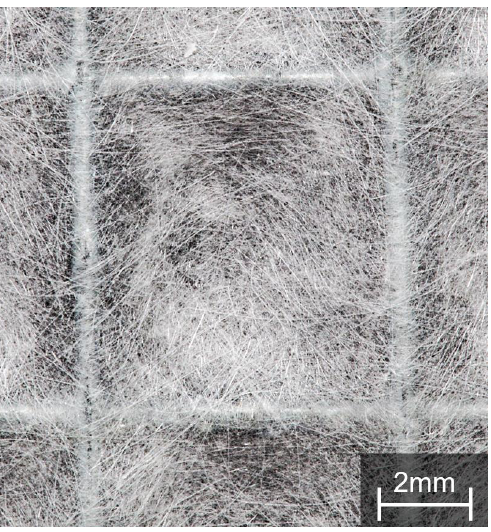
Figure 3. SEM image of a filter material (upstream view) consisting of 80wt.% micro glass fiber and 20wt.% PET fiber with a surface weight of 7.5gm − 2 . Inset: SEM image of the cross-section view of the same filter material.